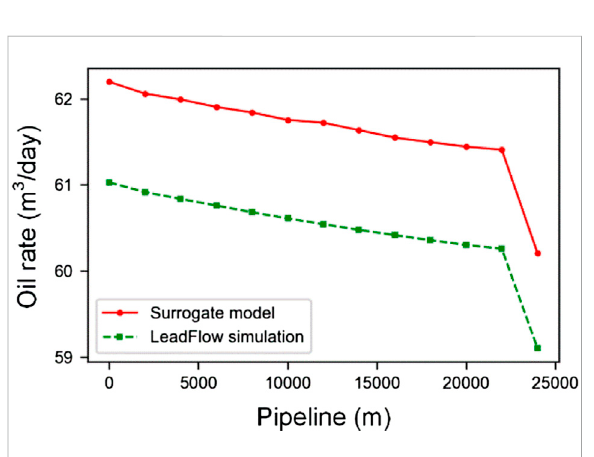
FIGURE 9 The change of oil rate along the pipeline between surrogate mode and LeadFlow simulation.